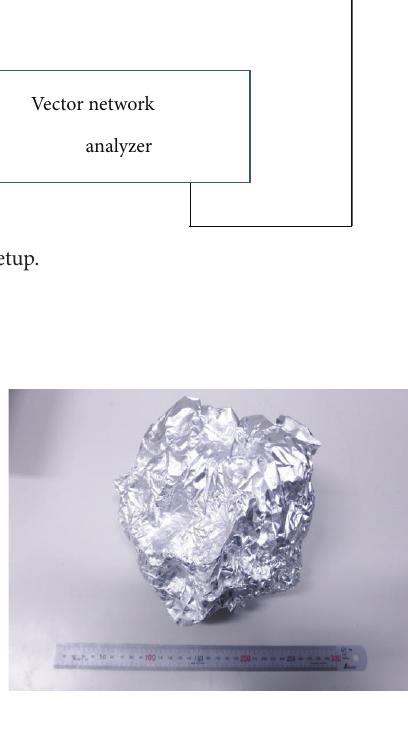
marked several frequency regions with fluctuations of more than 15 dB at different angles, compared to sphere targets with only 5 dB of maximum fluctuations. The targets were positioned at 2.5 m from the baseline of the transmitter and receiver. The measurement scenario is depicted in Figure